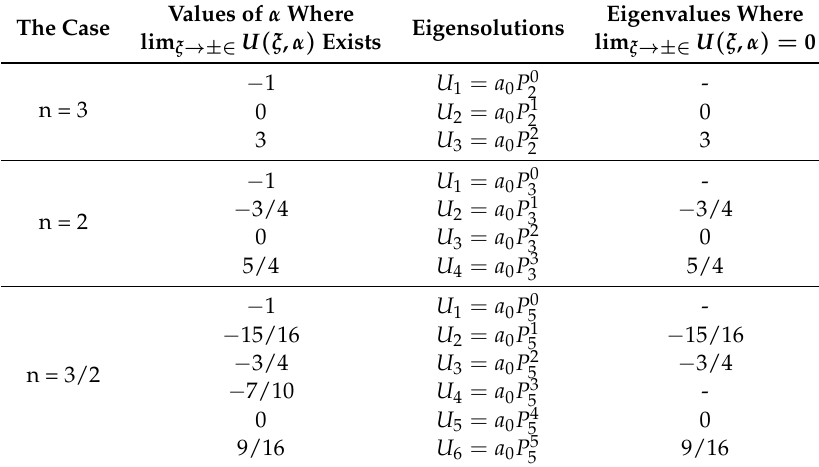
Table 1. Special cases for the non-eigenvalue and eigenvalue which satisfied the eigenvalue condition and then it is the zeros of the Evans function E ( α )